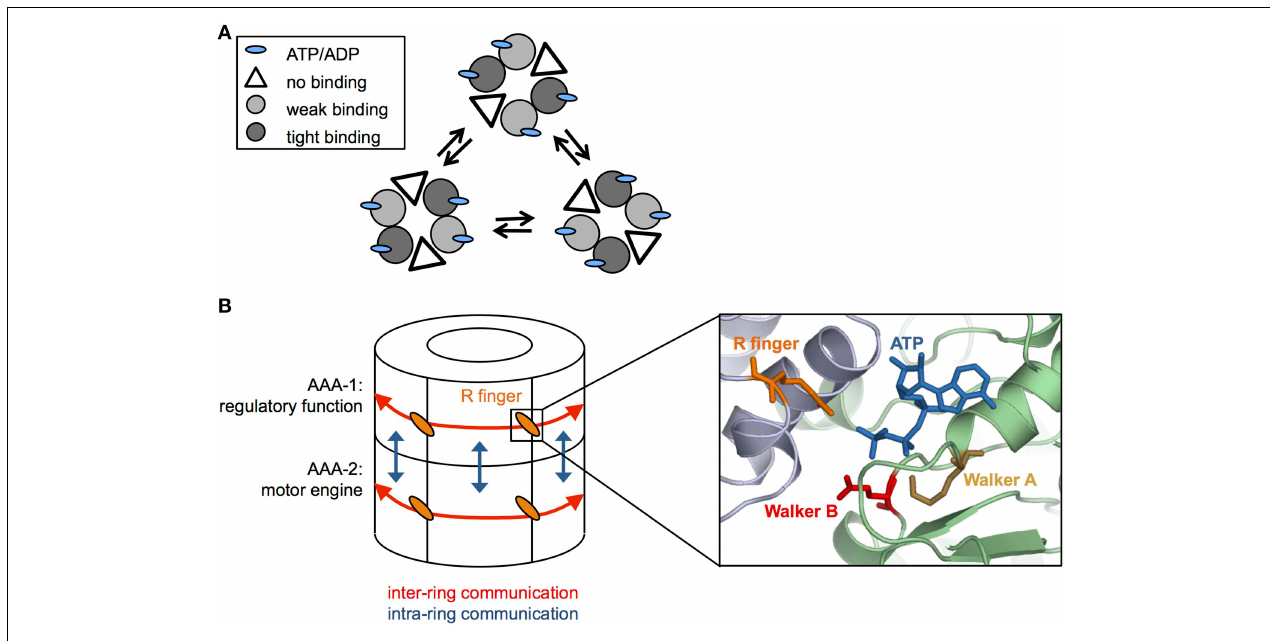
is mediated by conserved arginine fingers that are located at the subunit interfaces, contacting the γ -phosphate of ATP bound at an adjacent subunit and allowing to signal nucleotide states across the ring. Positions of conserved glutamate and lysine residues of Walker A and B motifs, respectively, ATP and arginine fingers are given based on (Lee et al., 2007). AAA-1 has mainly a regulatory function and controls ATP turnover at AAA-2, which represents the main motor engine for substrate